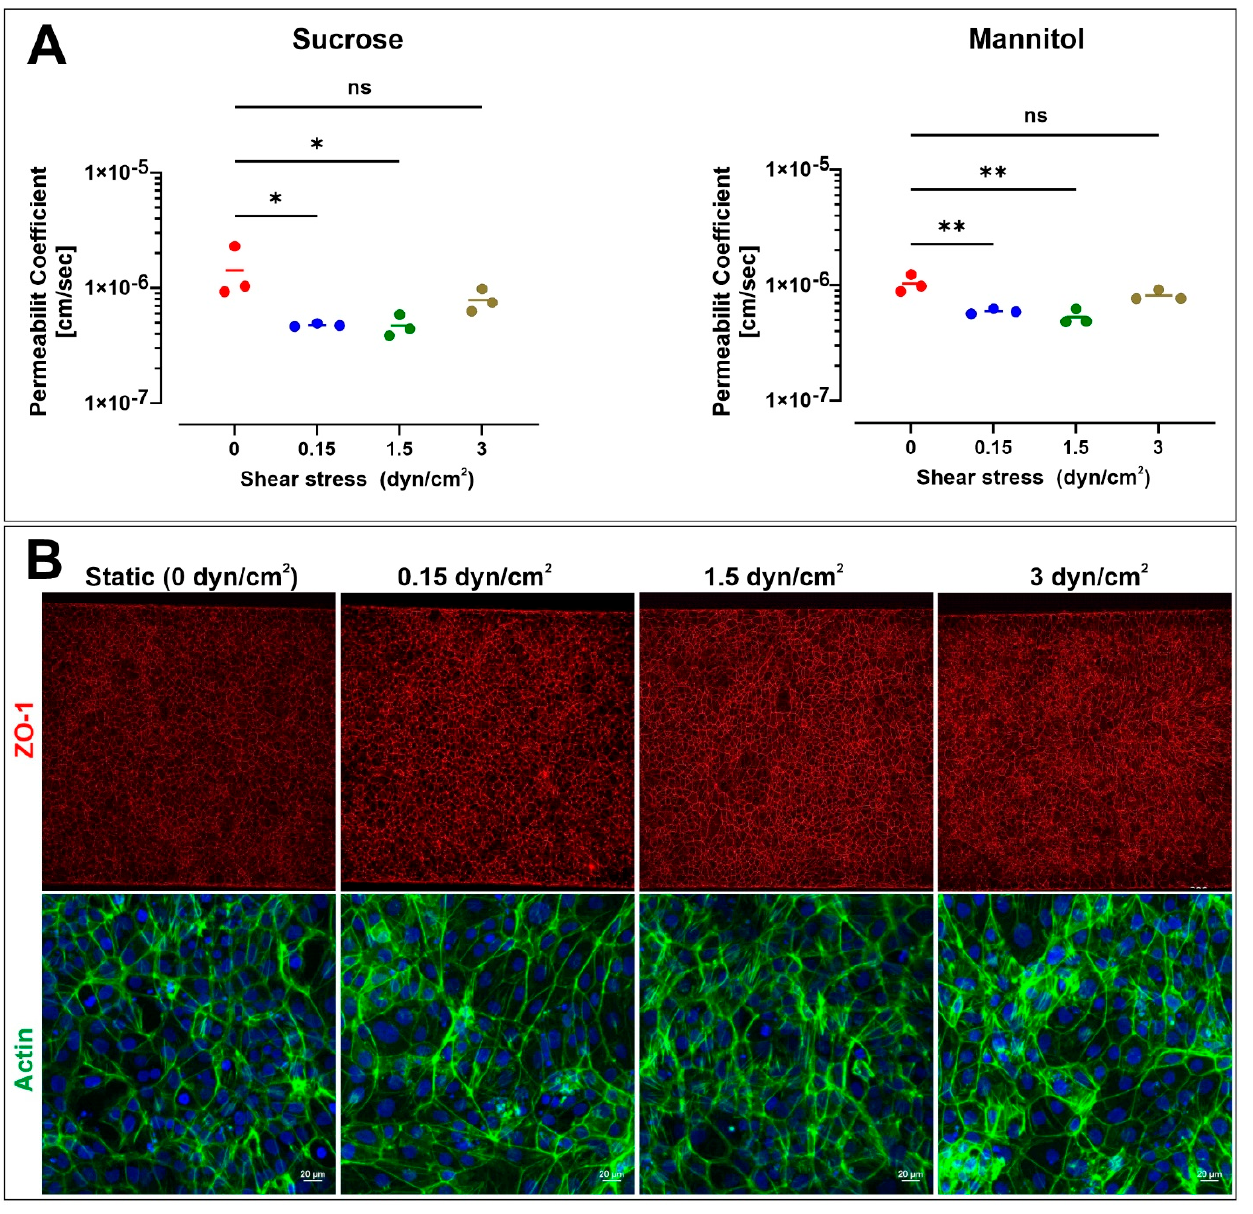
Figure 4. Effect of shear stress on the permeability coefficient of sucrose and mannitol in a microfluidic chip. ( A ) Note the effect of shear stress on the permeability of both paracellular markers. ( B ) Representative immunofluorescence images of iBMEC monolayers fixed and stained after 48 h at 0, 0.15, 1.5, and 3 dyne/cm 2 . ZO-1 (red) and F-actin phalloidin (green). n = 3 biological replicates. * p < 0.05 and ** p < 0.001 assessed by one-way ANOVA, followed by Tukey’s multiple comparisons test.